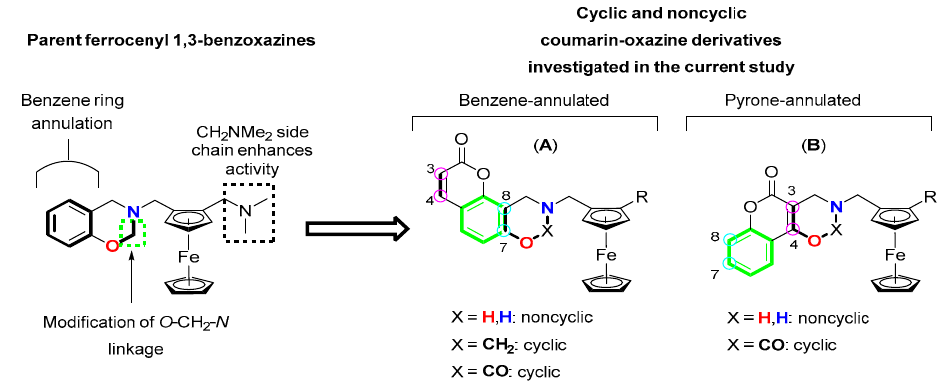
Figure 2. Design of ferrocenyl coumarin-oxazine hybrid compounds pursued in this study. Synthesis of the target compounds was achieved by reductive amination of formyl hydroxycoumarins 9 and 14a – c with ferrocene methylamines 10a , b , prepared according